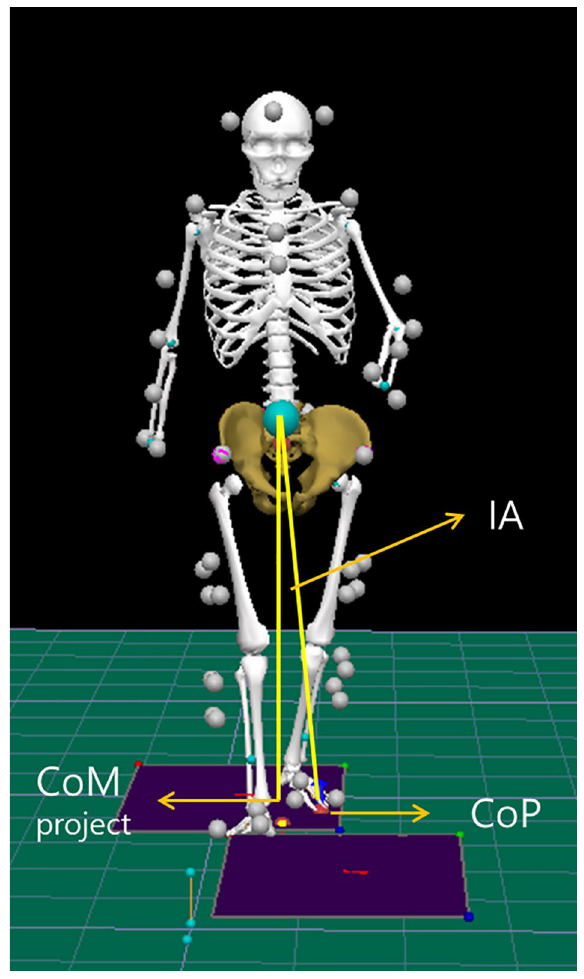
Figure 1. Fifty-six reflective markers were attached to the head, trunk, pelvis, arm, forearm, thigh, leg, and foot segments. IA was obtained with CoM, CoM projection on XY plane, and CoP. Vector1 from CoM to CoP projection, and vector2 from CoM to CoP were obtained. The angle between vector1 and vector2 was obtained with the right-hand rule by Visual3D. The angle obtained was projected to the YZ plane (sagittal) and XZ plane (frontal). When CoM did not go lateral to the CoP in the frontal plane, the left limb IA was the positive sign and the right limb IA was the negative sign. Therefore, we changed the right frontal plane IA sign by multiplication of (− 1). This image is obtained from Visual3D (ver6.2). IA inclination angle, CoM center of mass, CoP center of